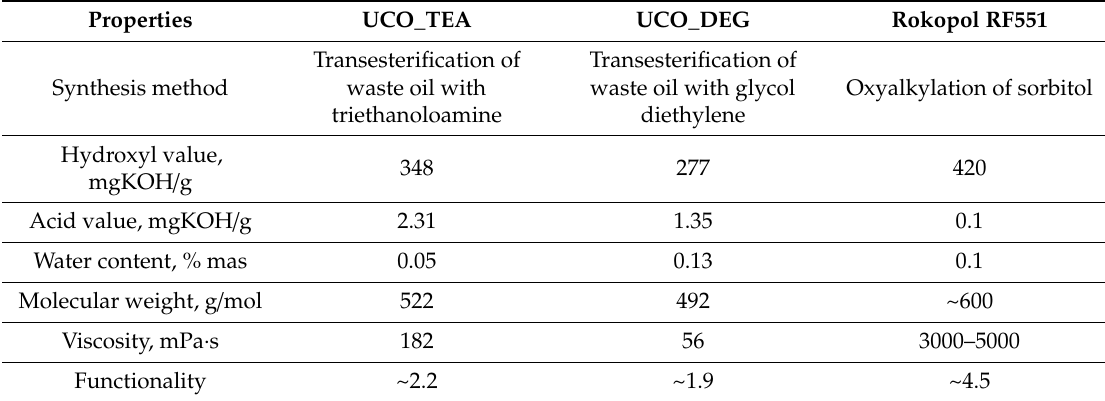
Table 1. Characteristics of polyols.